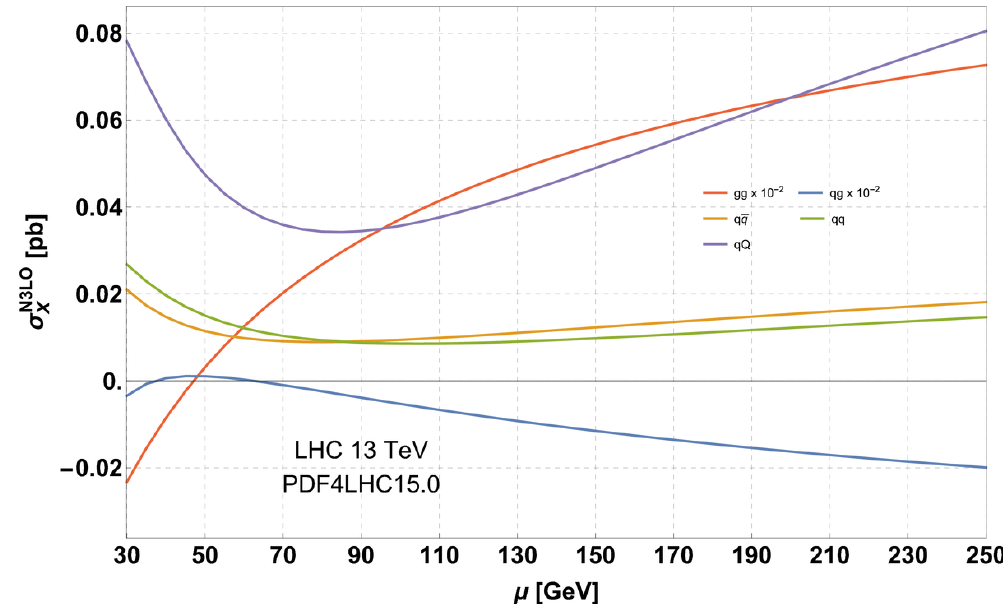
Figure 3 . The (cid:12)gure displays the contribution of N 3 LO coe(cid:14)cient function to the Higgs boson production cross section for the gg (red), qg (green), q(cid:22) q (orange), qq(blue) and qQ(purple) initial state as a function of the perturbative scale (cid:22) . The gg and qg coe(cid:14)cient function were rescaled uniformly by a factor of 10 (cid:0) 2